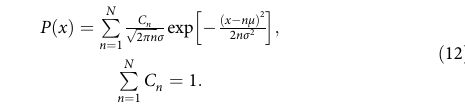
Table 5. Because log L log was larger than log L norm , we adopted the parameters of the log-normal distribution. Curve fi tting . The maximum-likelihood estimation (MLE) method was used to fi t the obtained data to the model equations. The Limited-Memory Broyden Fletcher Goldfarb Shanno algorithm 34 was employed to calculate the diffusion displacement by Eq. (10). A generalized reduced gradient nonlinear optimization method 35 was used to obtain the MSD by Eqs. (7) and (8), the intensity histogram by Eqs. (12) and (13), the EC 50 / h by Eqs. (14) and (15), and the EC 50 /IC 50 by Eqs. (16) and (17). For the fi ttings, the commercially available software Microsoft Excel (Microsoft) was used. The molecular lateral diffusion was analyzed using Eq. (10) with an in- house-developed program written in Python (https://www.python.org). The least squares method along with the Levenberg Marquardt method 36 were used to fi t